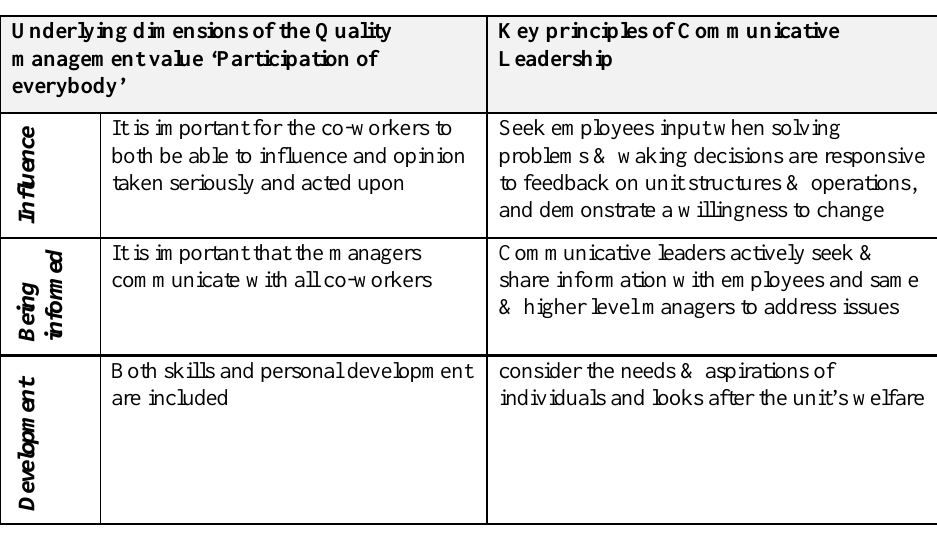
Table 2 – The result of the analysis of the underlying dimension of the health related Quality Management value ‘Participation of everybody’ versus the description of the key principles of Communicative Leadership.